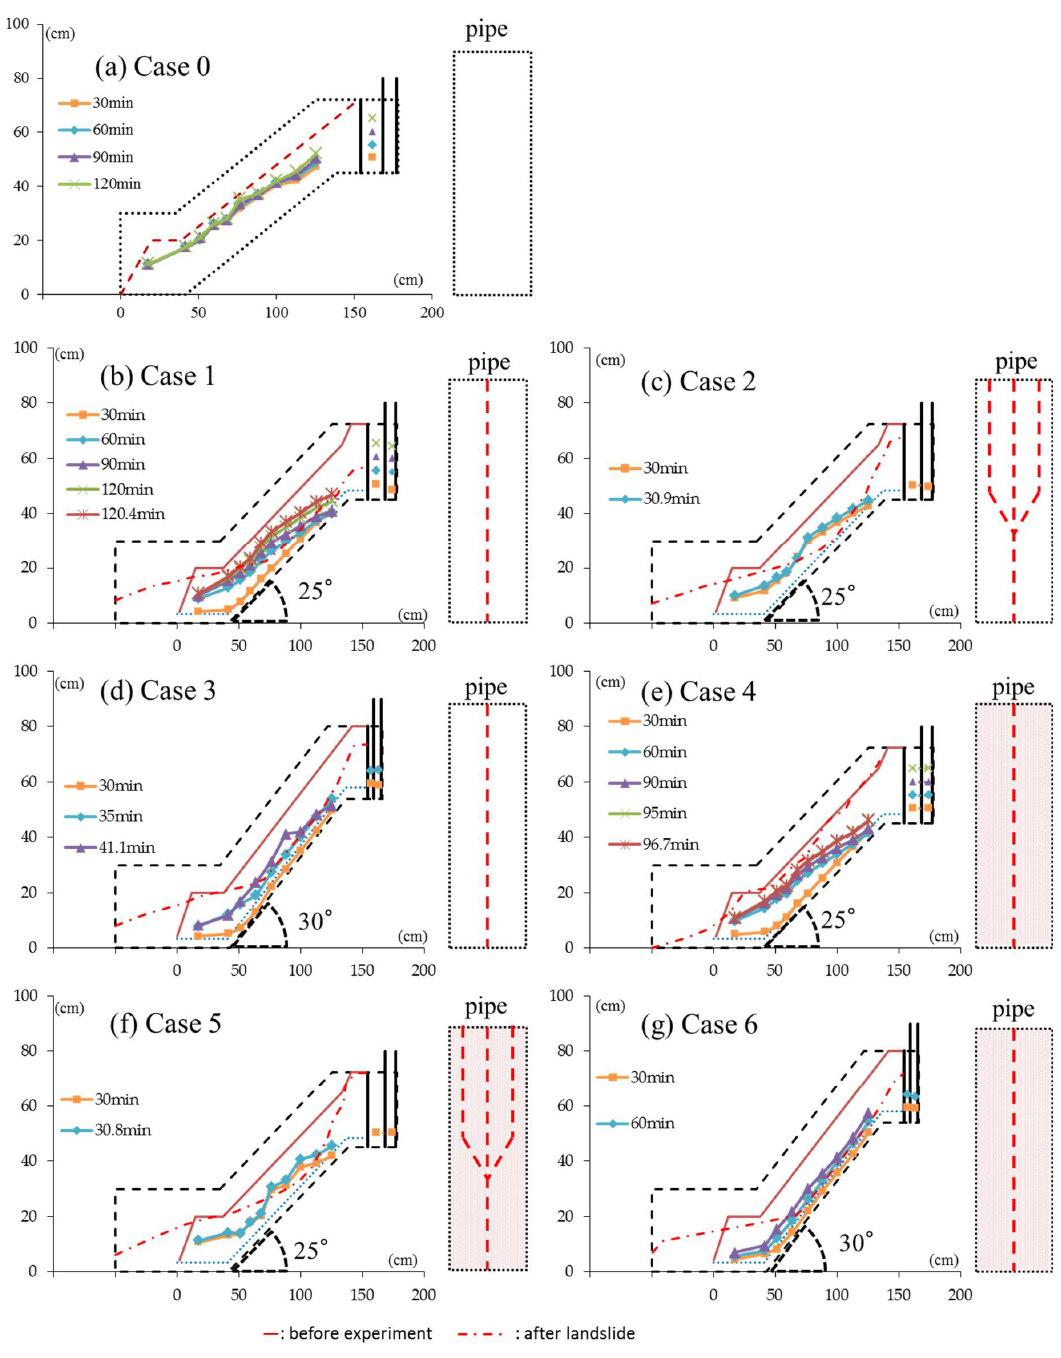
Figure 7. The distribution of the pore water pressure and the form of the landslide in each case. The figure shows that the pore water pressure, which we measured, increased as the water supply level rose over 30 min passing. ( a ) The pore water pressure was already high after 30 min, and did not vary significantly afterwards. ( b , d , e , g ) The pore water pressure was low after 30 min and increased with the water supply level. ( b , e ) pore water pressure was high around the transitional area of degree at 60 min passing especially. ( c , f ) The pore water pressure was high around the confluence of the artificial pipes after 30 min. ( a , c , f ) show that the form of the landslide was planar, while ( b , e ) show that the form of the landslide was rotational. ( d ) shows that the surface of the model slope flowed away.